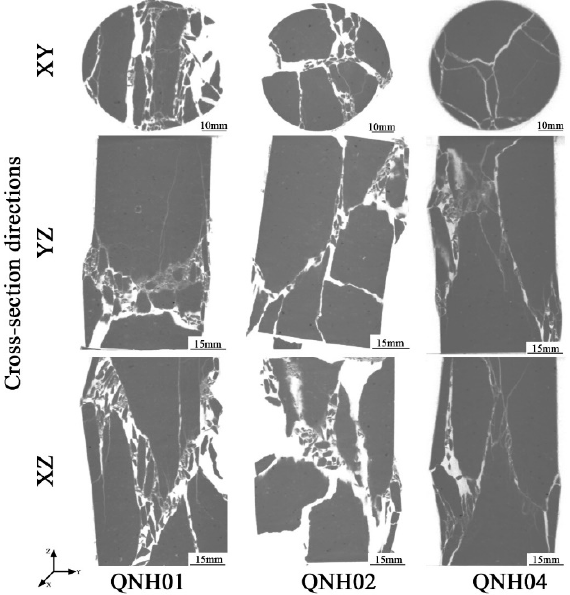
Figure 10. Three corresponding views of the strongly welded tuff specimens were scanned with a linear accelerator CT. From top to bottom, the cross-sections are of the X-Y plane (parallel to the bottom of the sample), the Y-Z plane, and the X-Z plane, respectively.